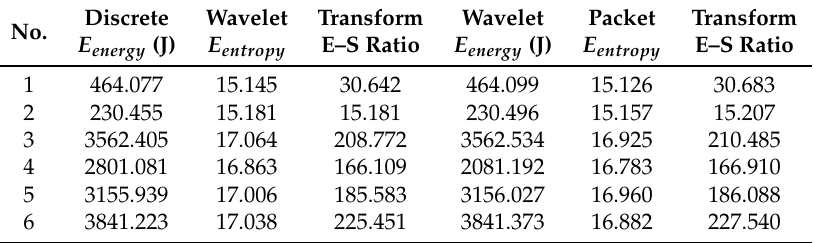
Table 1. Comparison of different transformation modes under the basis function of coif